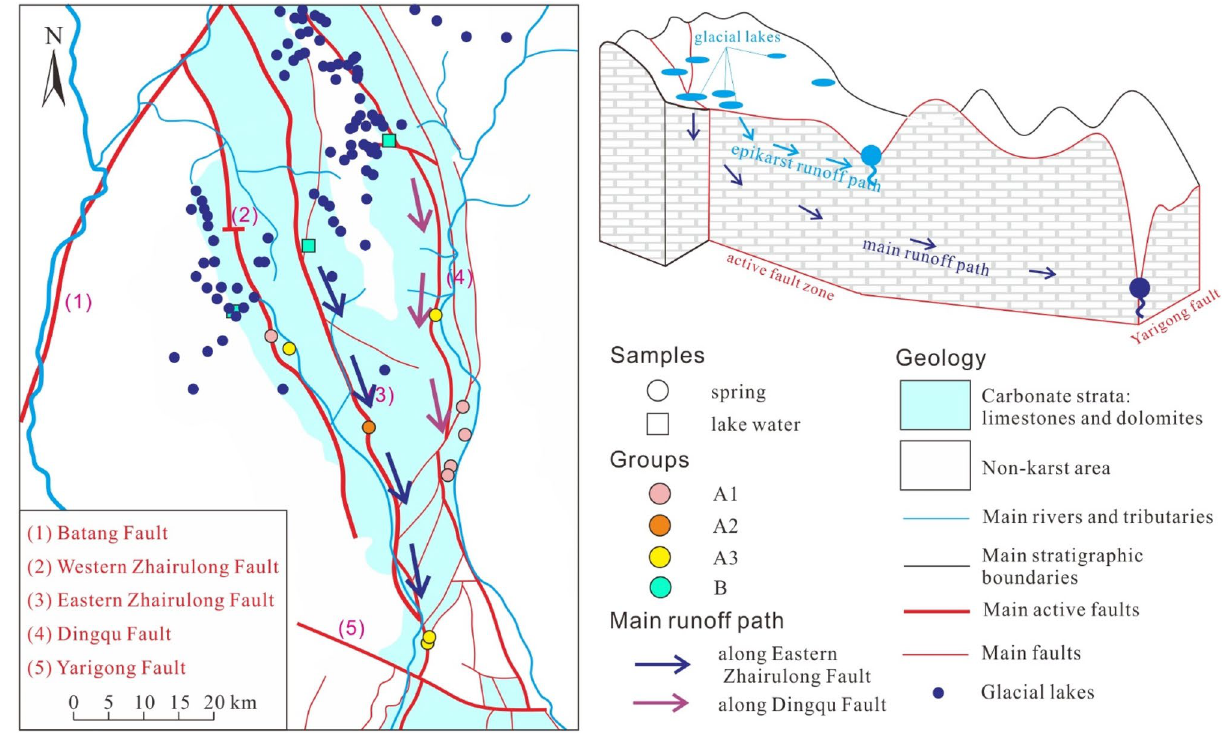
Figure 12. Recharge–runoff conceptual diagram and main runoff path of karst groundwater. The faults, rivers, are area of carbonate rock distribution are from the China Geological Survey (https:// www. cgs. gov. cn/). The figure was generated using CorelDRAW